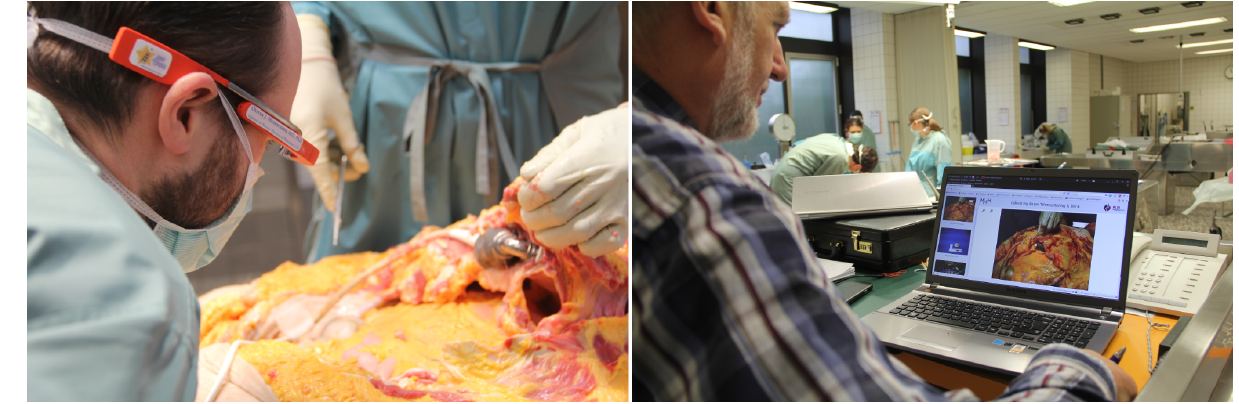
Figure 2. A forensic pathologist taking a picture of the situs using Google Glass during an autopsy (left). The Blink-app app transmits the image to the laptop where it is immediately presented to the attending detective and the public prosecutor